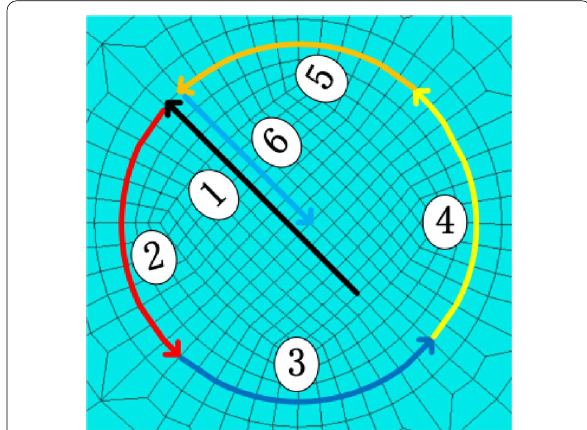
Figure 19 Welding method is the new 6-sections welding path